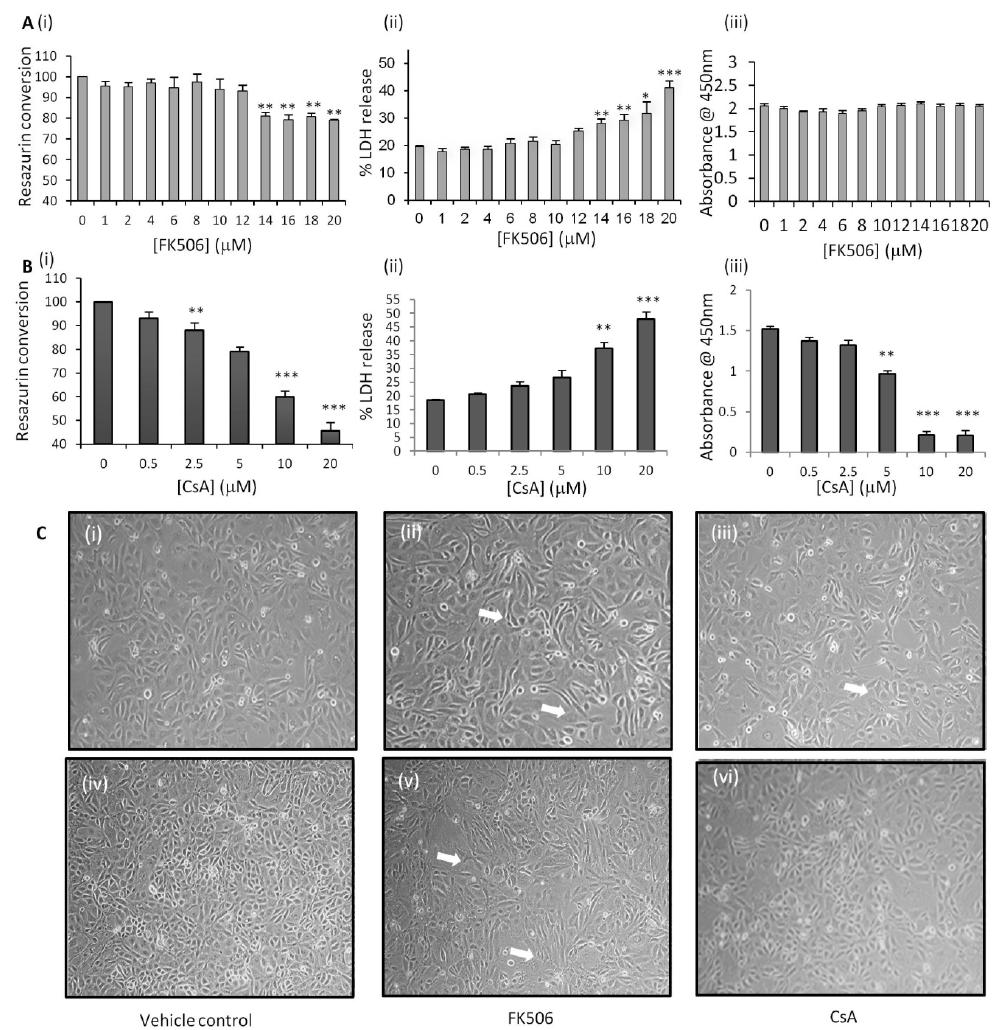
Figure 2. Effects of FK506 on HK-2 cells. HK-2 cells cultured on 96-well plates were treated with ( A ) FK506 across a concentration range of 0–20 µ M or ( B ) CsA across a concentration range of 0–20 µ